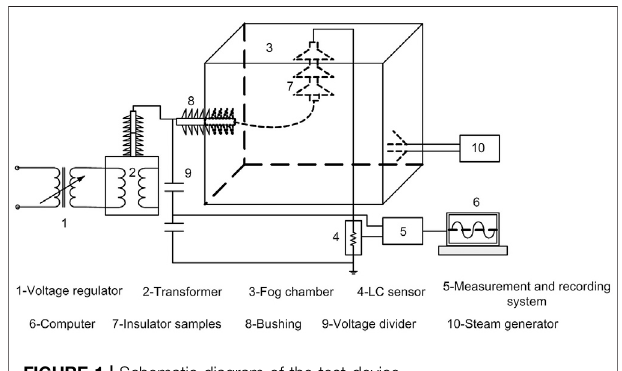
FIGURE 1 | Schematic diagram of the test device.